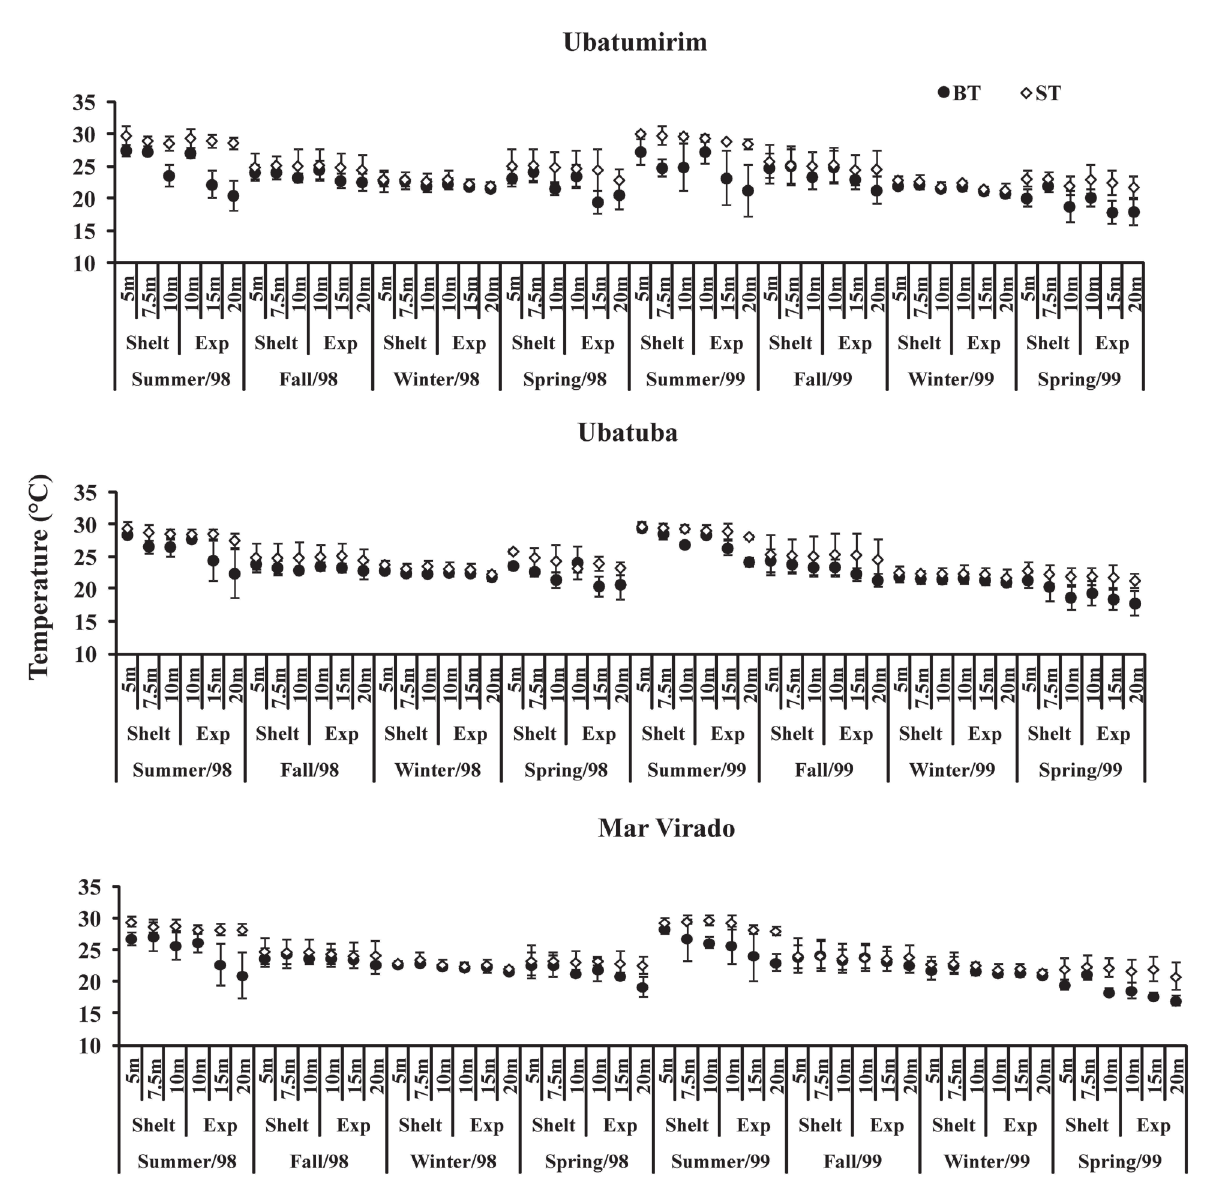
Figure 2. Bottom (BT) and surface (ST) temperature variation per seasons, areas and sampling points in 1998 and